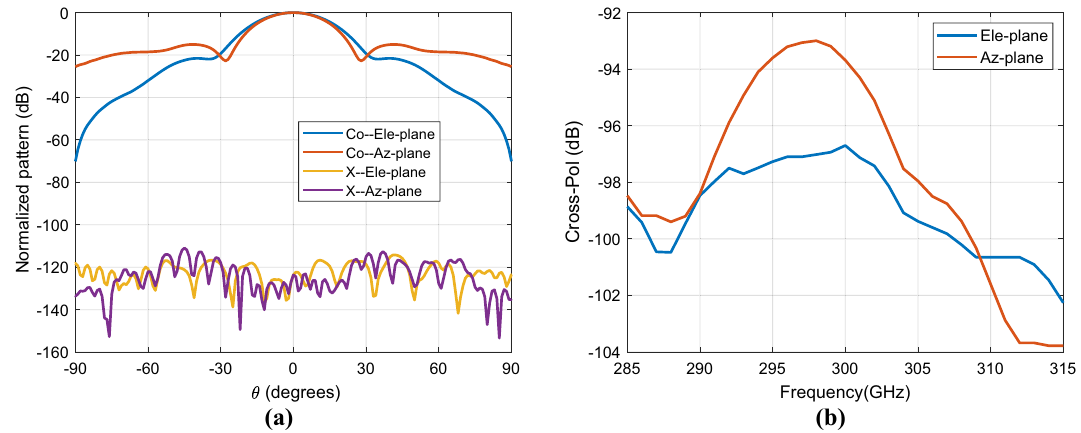
Figure 9. Simulated ( a ) normalized cross-pol radiation patterns at 300 GHz and ( b ) cross-pol level of the FPC antenna prototype.